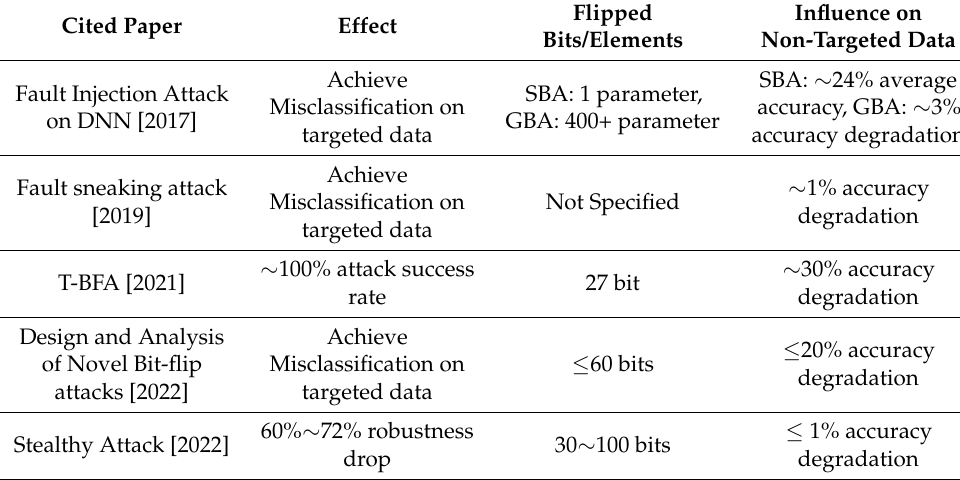
Table 6. The results of targeted attack-related work.